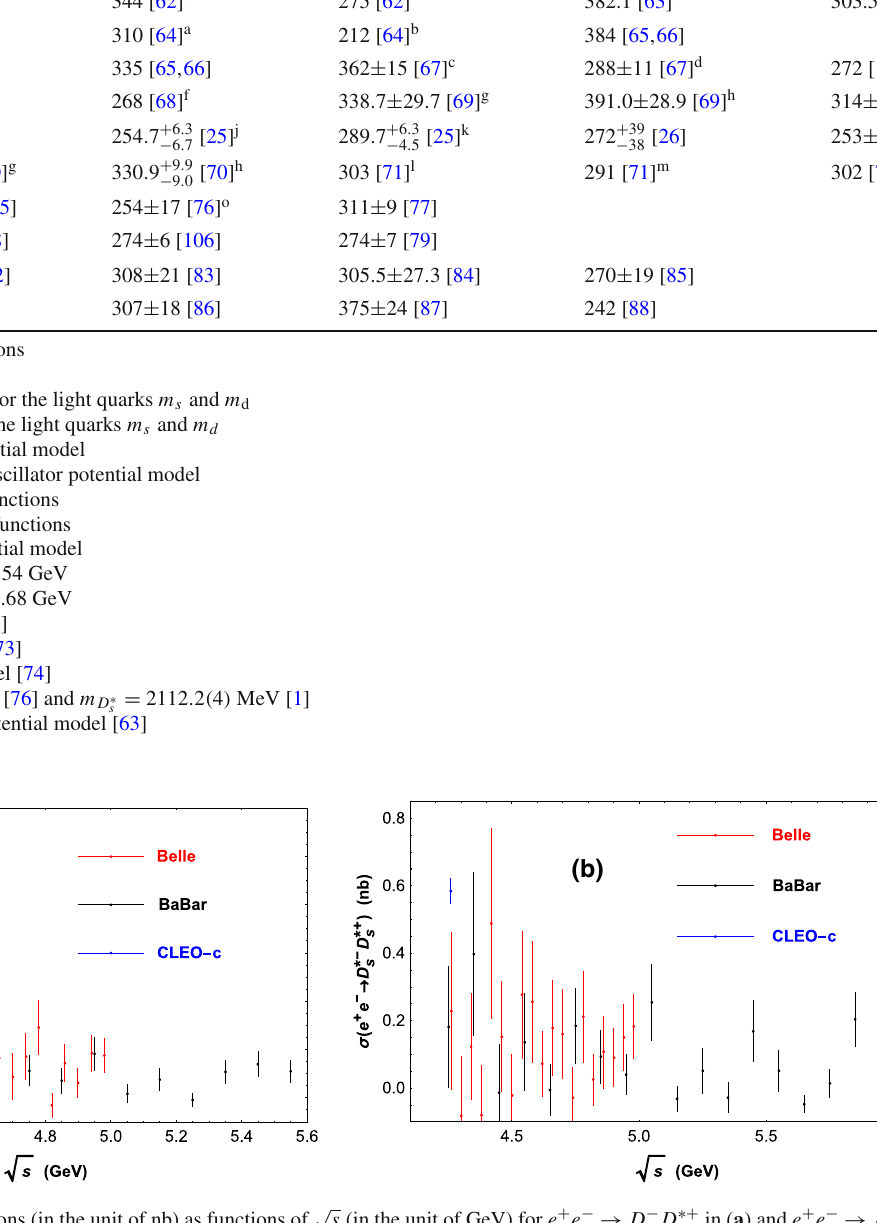
Table 4 The theoretical values of decay constant f D ∗